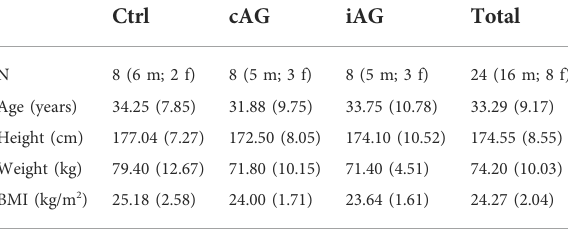
TABLE 1 Demographic information of the AGBRESA participants. All measures were recorded upon admission and are presented as Mean (SD). No statistically signi fi cant difference was detected for any of the group measures ( p < 0.05). cAG: continuous AG; iAG: intermittent AG; Ctrl: Control group; BMI: body max index; m: males, f: